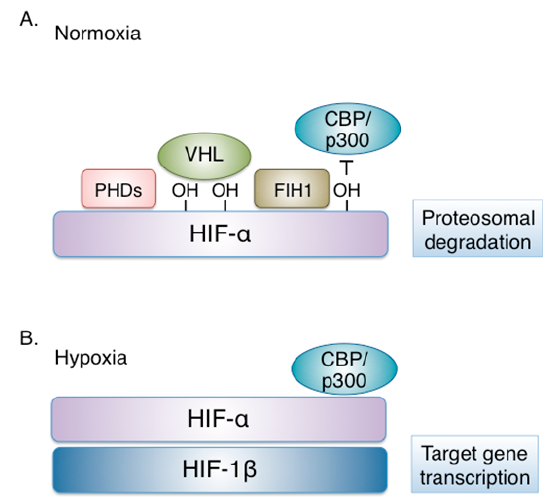
Figure 1. Regulation of hypoxia-inducible factor (HIF) by oxygen. ( A ) Under physiological oxygen concentration (Normoxia), HIF- α isoforms are modified by oxygen-dependent prolyl-hydroxylases (PHDs), recognized by the von Hippel–Lindau (VHL) tumor suppressor protein, ubiquitinated and targeted to the proteasome for degradation. In addition, HIF- α modification by FIH (factor-inhibiting HIF), an oxygen-sensitive asparaginyl hydroxylase, disrupts interaction with the transcriptional co-activators p300/CBP and impairs residual HIF transcriptional activity. ( B ) When oxygen becomes limited (Hypoxia), PHDs and FIH are inactive. The non-hydroxylated HIF- α is stable and dimerizes with HIF-1 β . The HIF heterodimer interacts with p300/CBP and activates the transcription of HIF target genes.